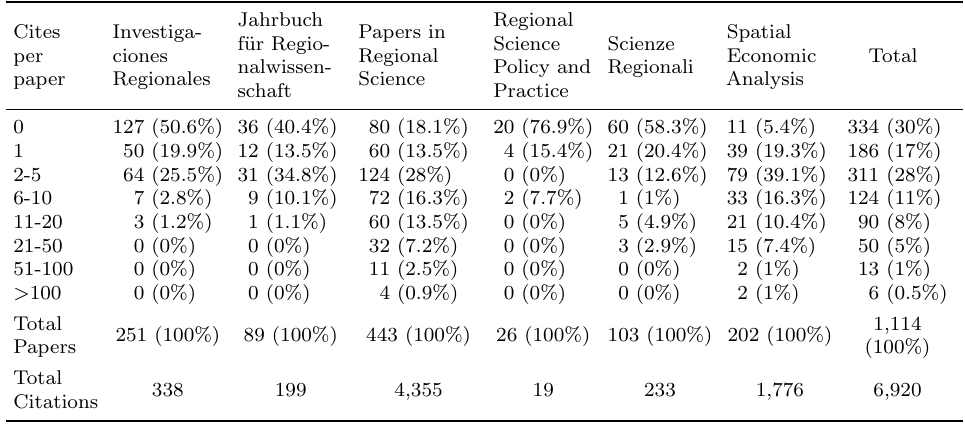
Table 1: Citation records in Regional Science journals